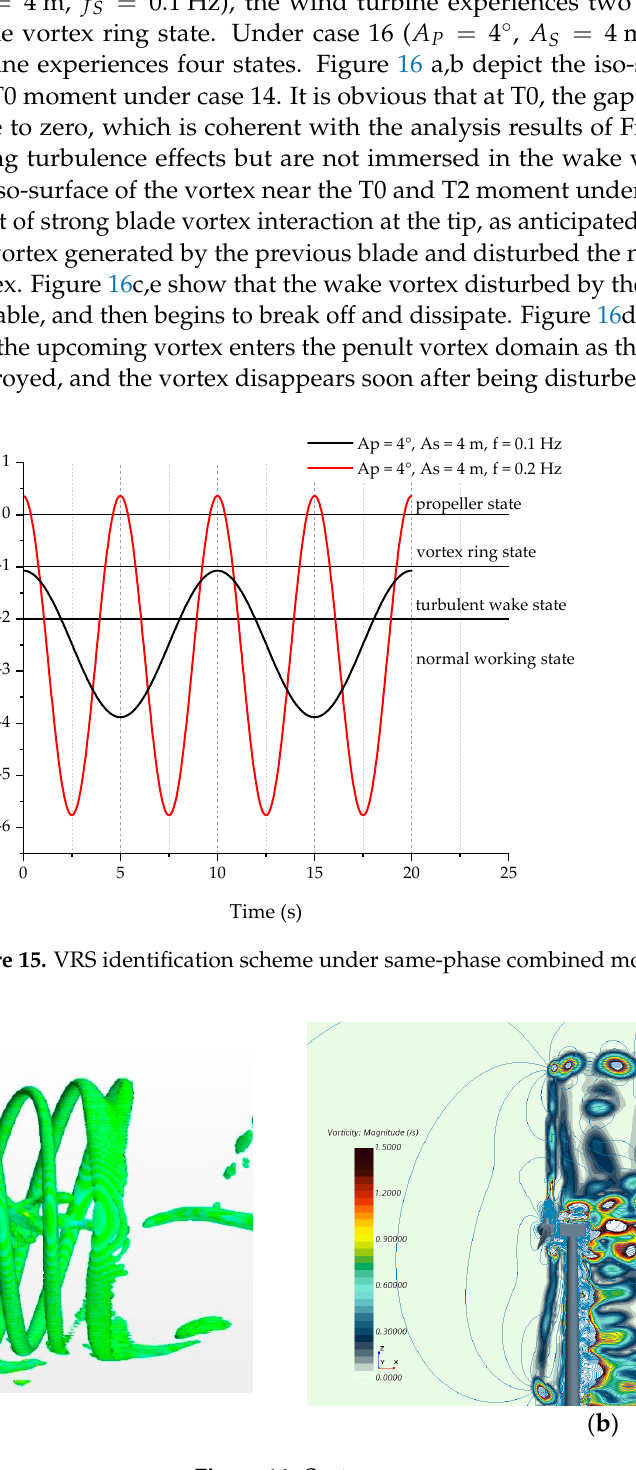
Figure 14. Power performance under same-phase combined motion. ( a ) Power variation versus time; ( b ) the average and extreme power.